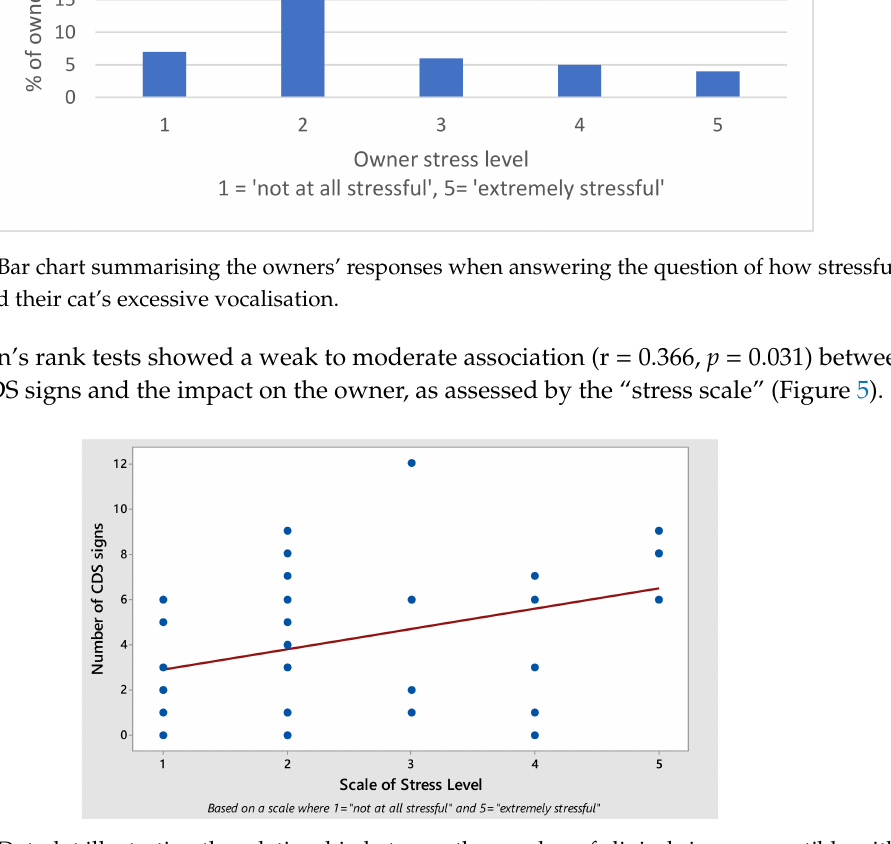
Figure 5. Dot plot illustrating the relationship between the number of clinical signs compatible with CDS and the negative impact on the owner. One dot represents “one owner and their cat” revealing the correlation between the degree of stress to the owner and number of CDS signs in their